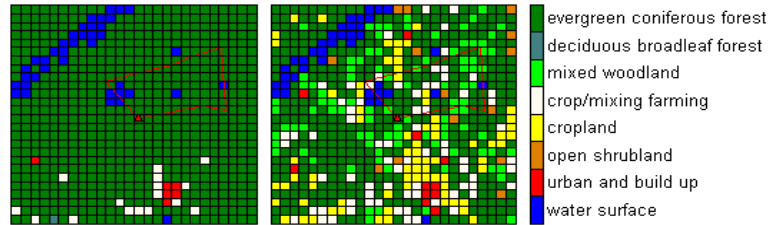
Figure 1. Land cover map of the study area according to the RAMS database ( left ) and CORINE database ( right ). The Norunda tower (red filled triangle) and the flight tracks (red line) for the low altitude surface flux measurements are inserted into the